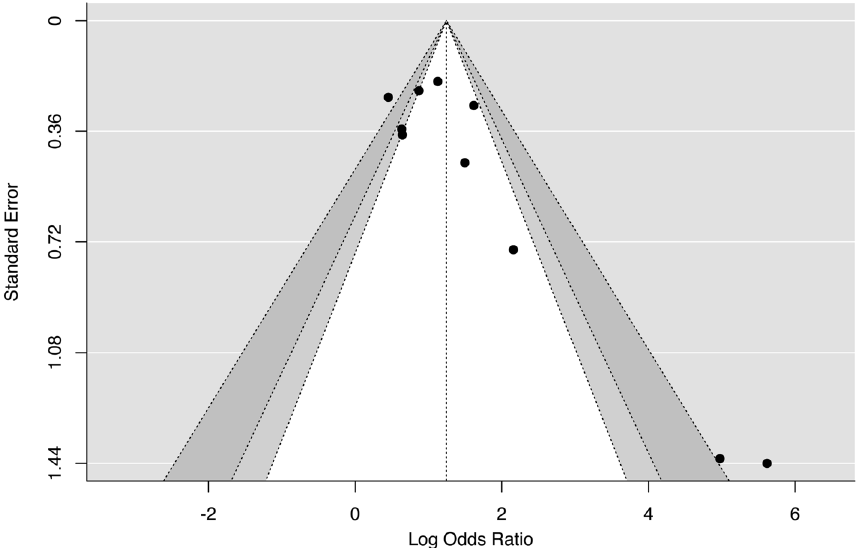
Figure 3. Funnel plot of meta-analysis for ten studies (I 2 = 77%). The association between chronic exposure to fluoride and cognitive deficit (p < 0.001). The figure was created using Review Manager v. 5.3 software (https:// train ing. cochr ane.